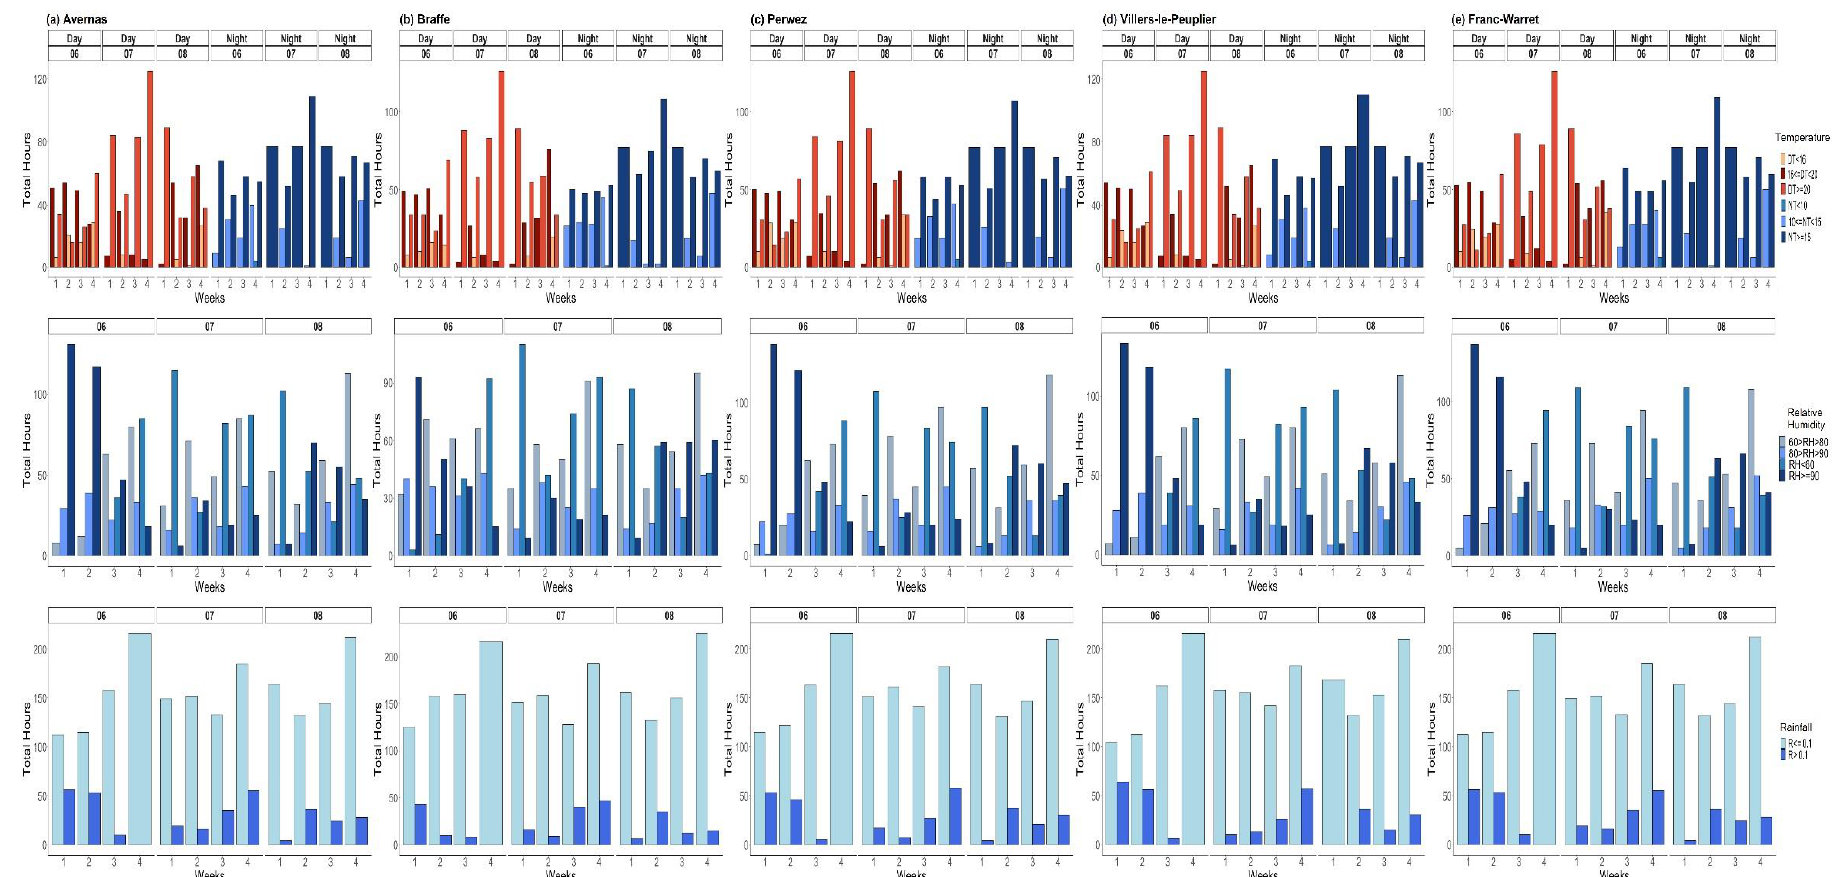
Figure 7. Distribution of weekly total hours for defined ranges of temperature (°C), relative humidity (%), and rainfall (mm) at Avernas ( a ), Braffe ( b ), Perwez ( c ), Villers-le-Peuplier ( d ), and Franc-Warret ( e ), Belgium, during the months of June (06), July (07), and August (08) 2018. DT and NT indicate daytime (7.00 a.m. to 8.59 p.m.) and nighttime (9.00 p.m. to 6.59 a.m. the following day) temperatures, respectively. The intervals of weather variables are provided in Table 2. (Note differences of scales on the y-axis.).